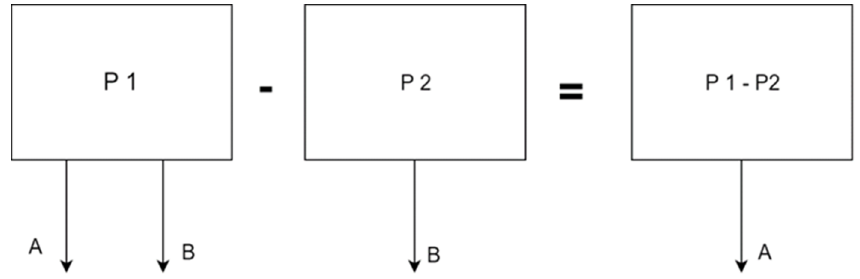
Figure A2. System expansion by substitution (reduction of functions). The investigated system (P1) delivers two products (A and B). Alternatively, product B can be produced by another system (P2). The substitution method proposes that the impact of producing A (only) by process P1, corresponds to the difference of impact between P1 and P2.